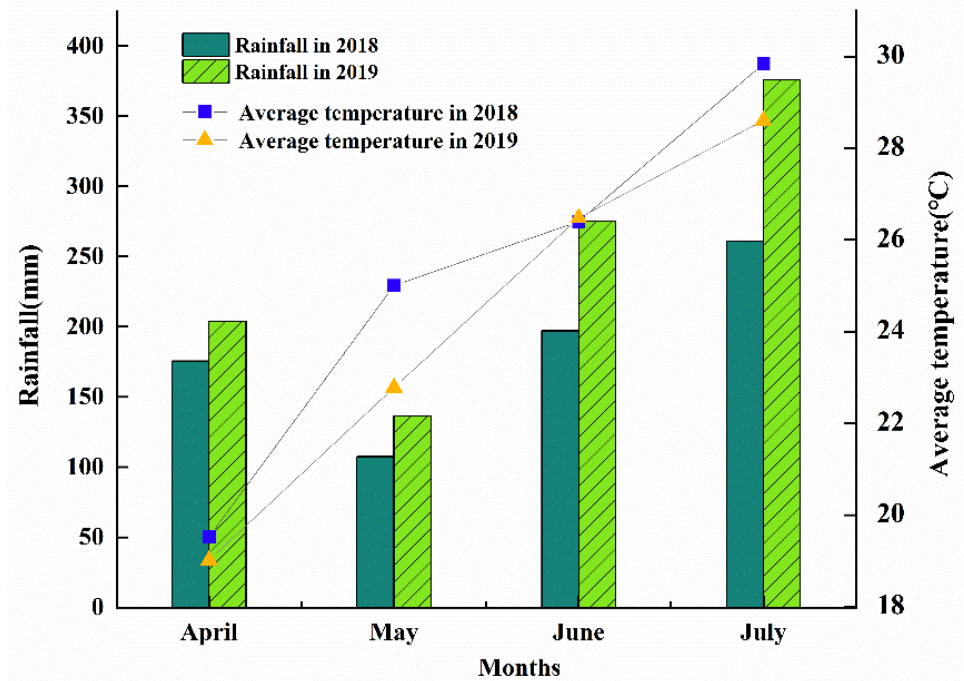
Figure 1. Monthly precipitation and average air temperature during maize and soybean growing period in two years.